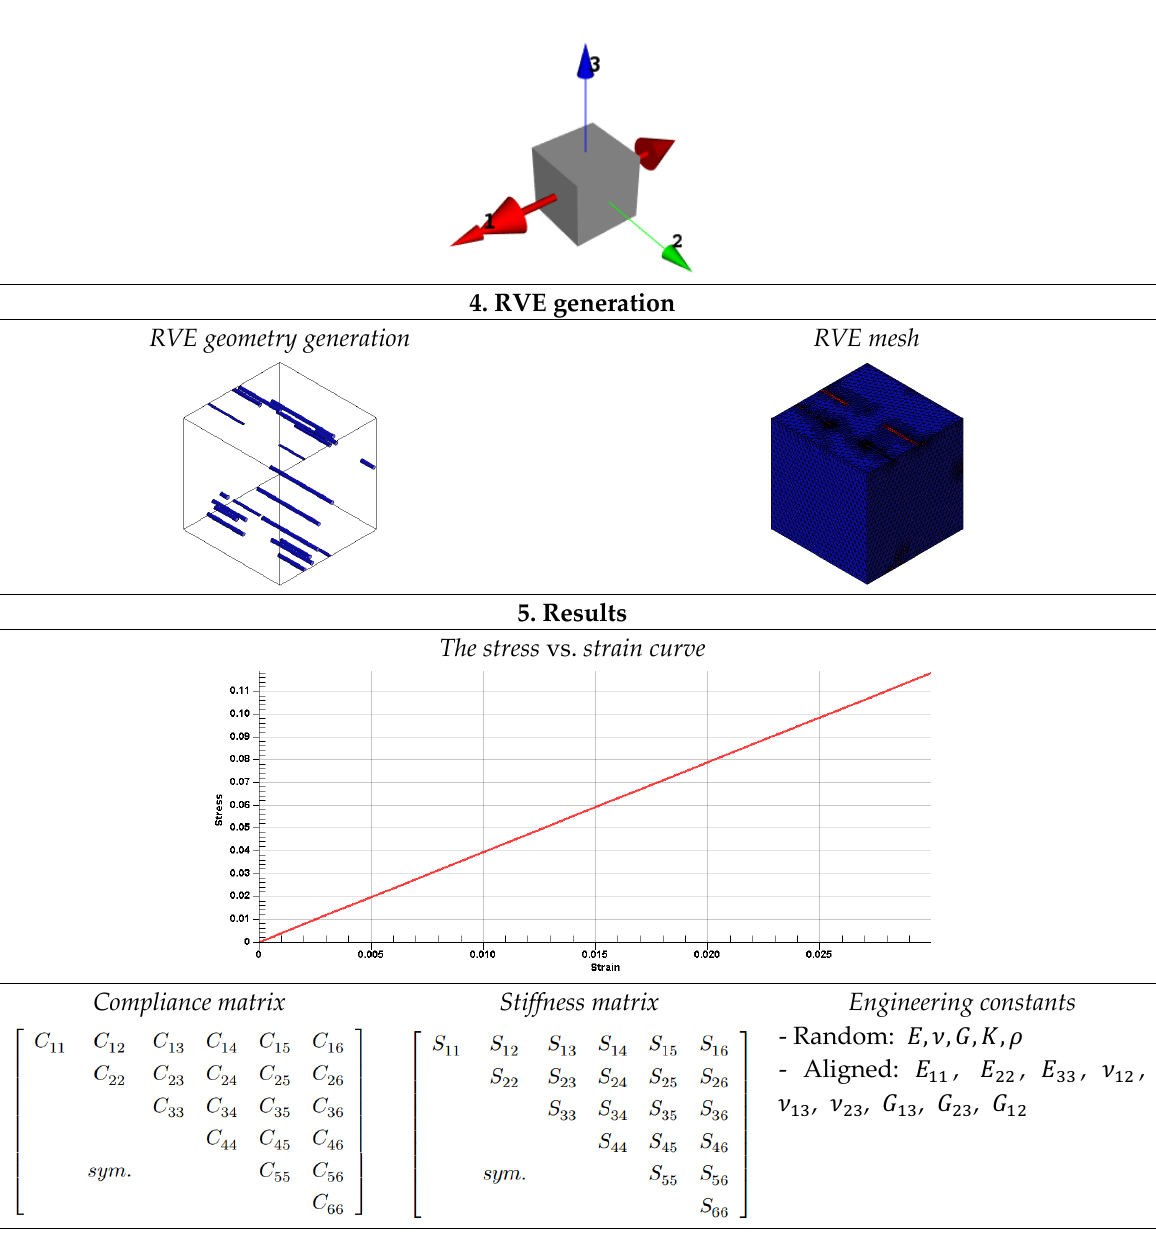
Figure 3. Homogenization process in Digimat-MF/FE.